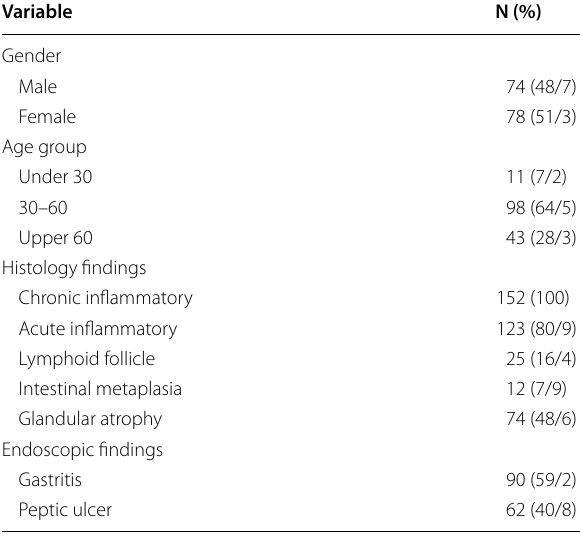
Table 1 Clinical and demographic characteristics of the